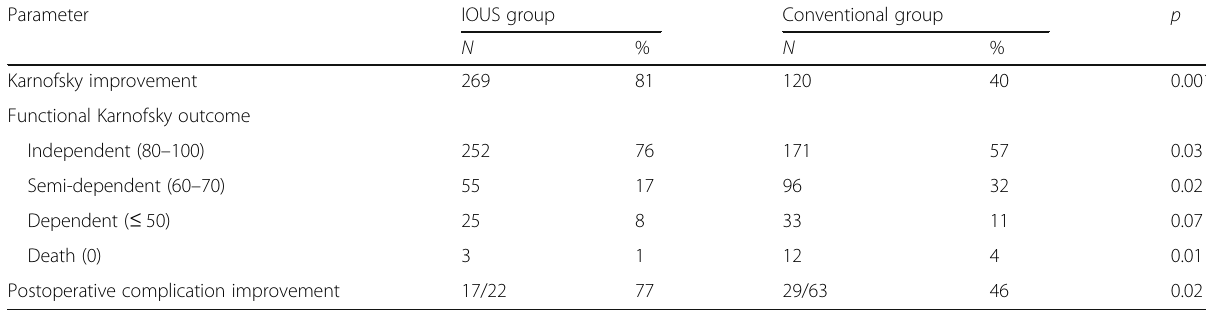
Table 4 Patients ’ outcome at postoperative third month regarding IOUS use Parameter